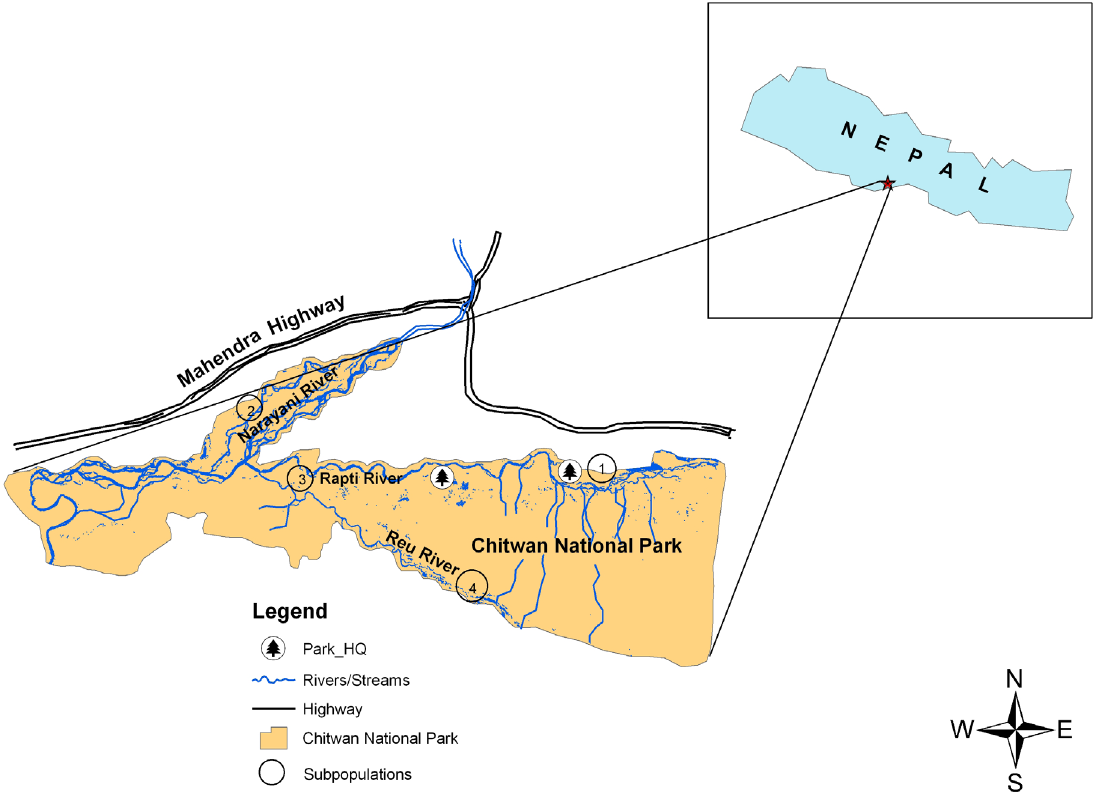
Figure 1. The study area is located on the southern lowlands of Nepal bordering